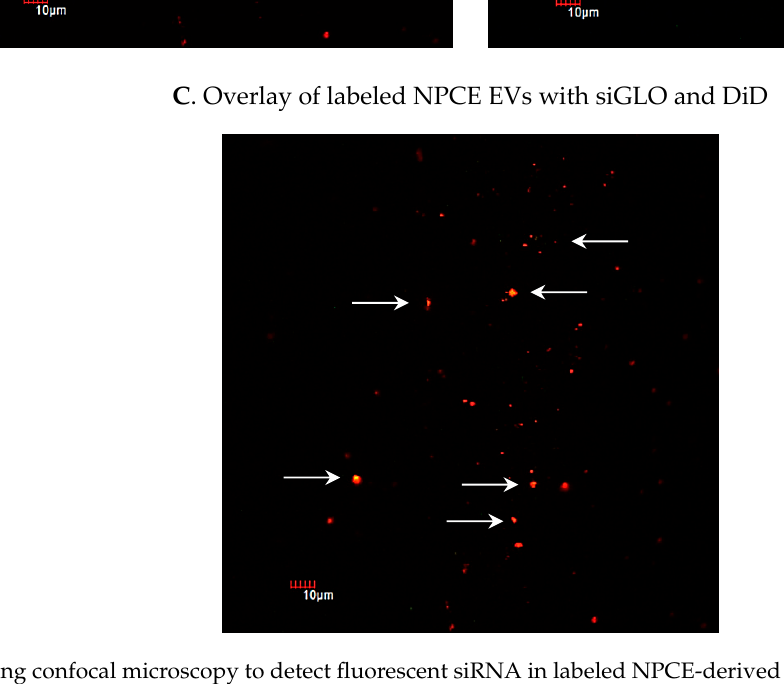
Figure 3. Using confocal microscopy to detect fluorescent siRNA in labeled NPCE-derived EVs and to track the loading efficiency of siGLO to NPCE EVs following electroporation. Purified NPCE EVs were labeled with fluorescent non-coding siRNA, siGLO (green) and with the membrane dye DiD (red). Pictures of NPCE EV’s membrane labeled with DiD ( A ) and NPCE EVs loaded with siGLO ( B ) were integrated ( C ) to determine the percentage of NPCE EVs positive for both DiD and siGLO markers. A total of 10 pictures from 3 different slides were analyzed for each treatment conducted in three independent experiments.